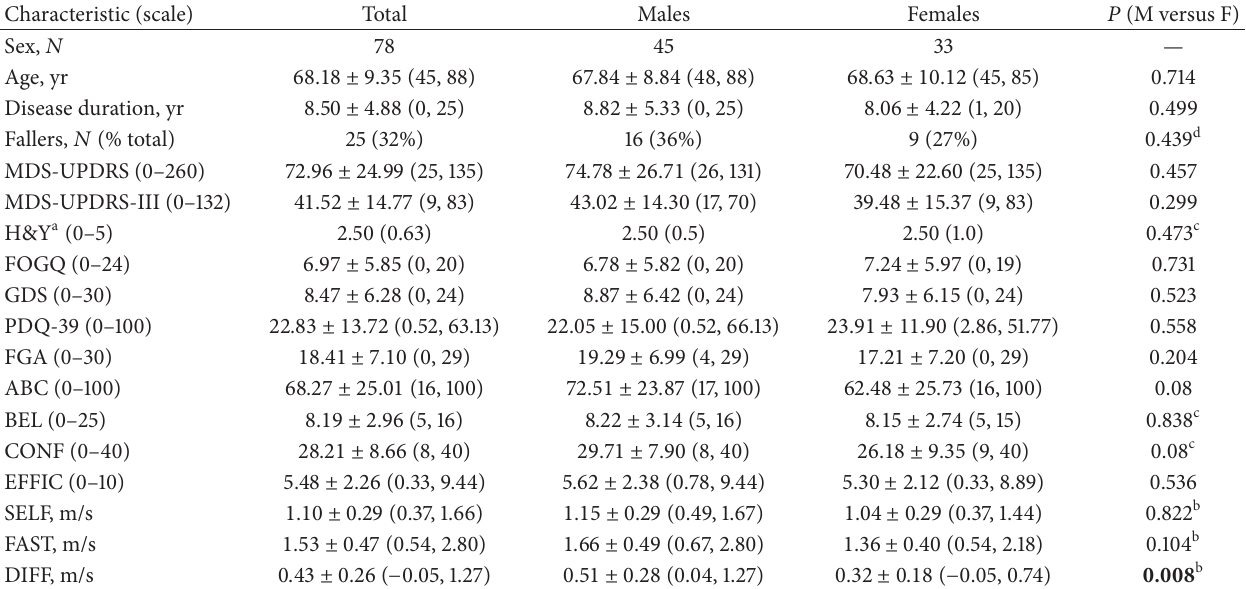
Table 2: Participant demographics and experimental